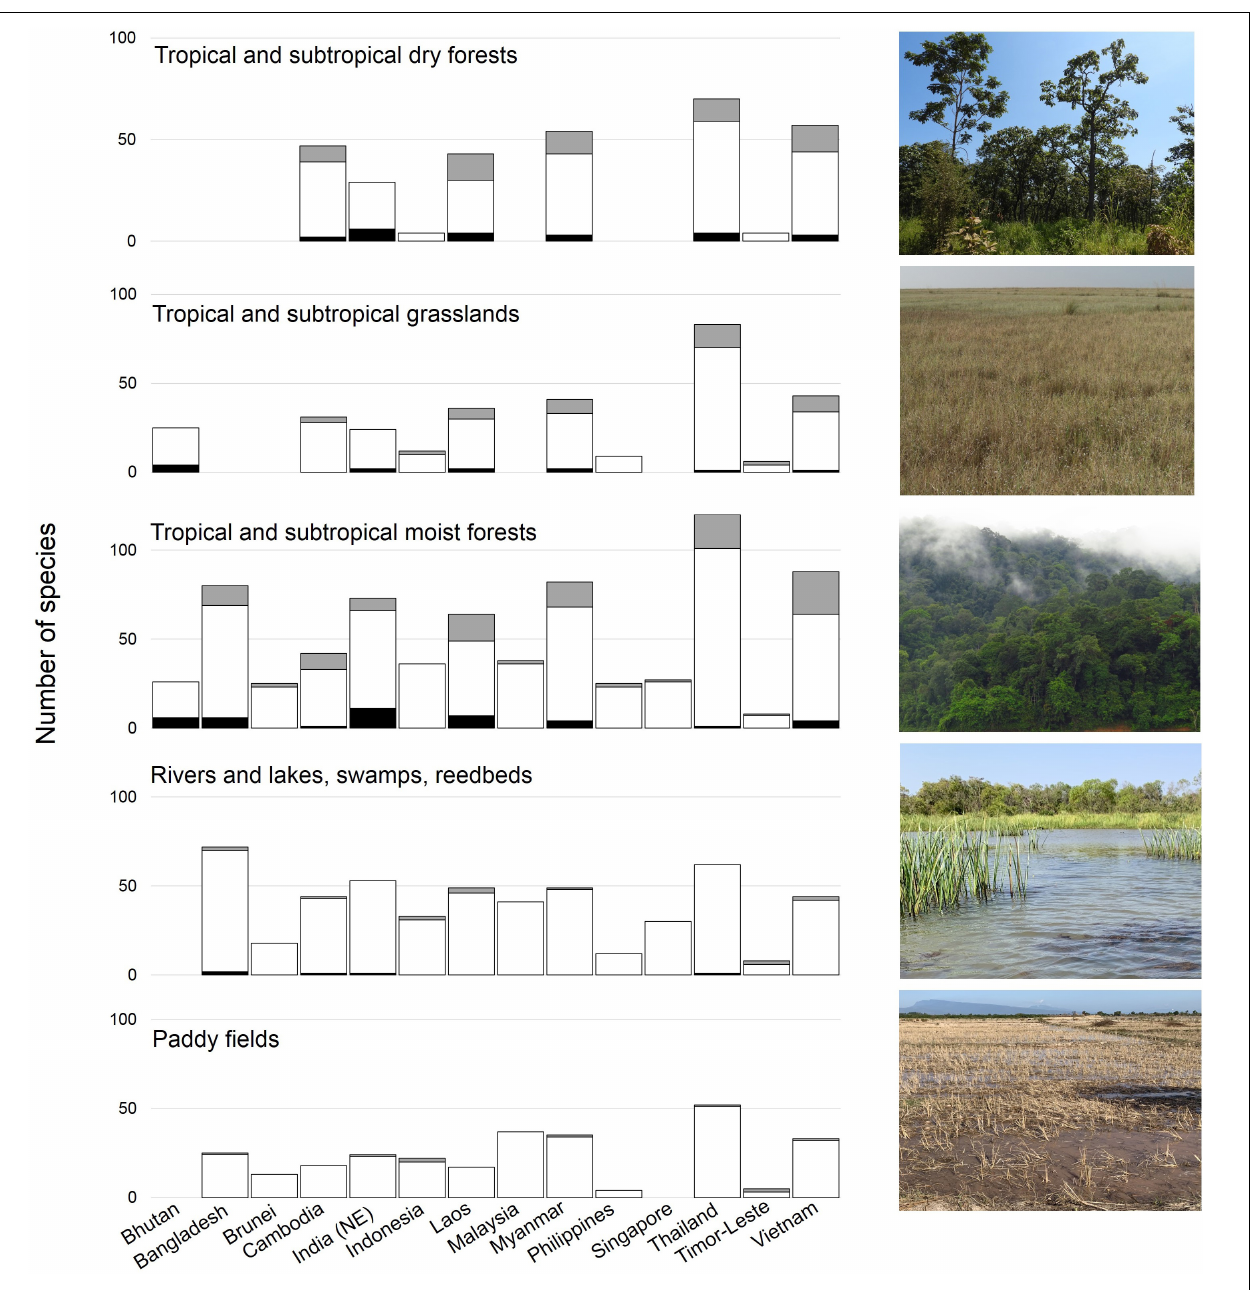
FIGURE 4 | Relative importance of biomes in tropical Asia for wintering migratory landbirds. Cultivated land, such as rice paddies, is among the most important of the human-modified landscapes for migratory landbirds (Image credits: Yong Ding Li). Grey bars (breeding species), white bars (wintering species), black bars (species on